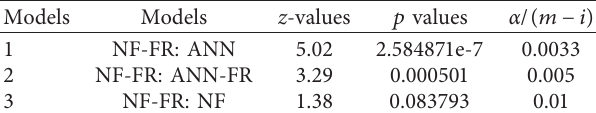
Figure 6: Density plot. Table 10: Results of the Holm statistical